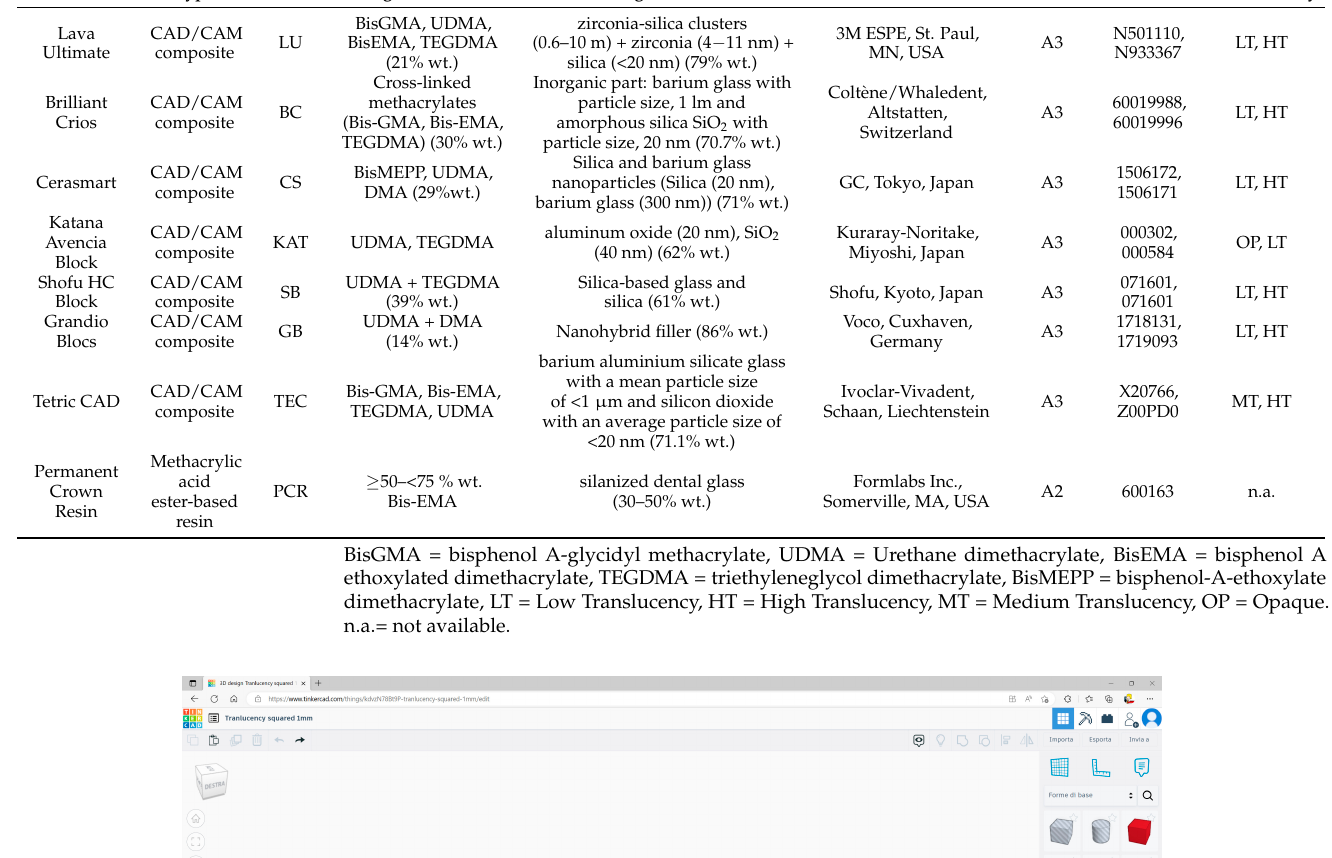
and slicing (Figure